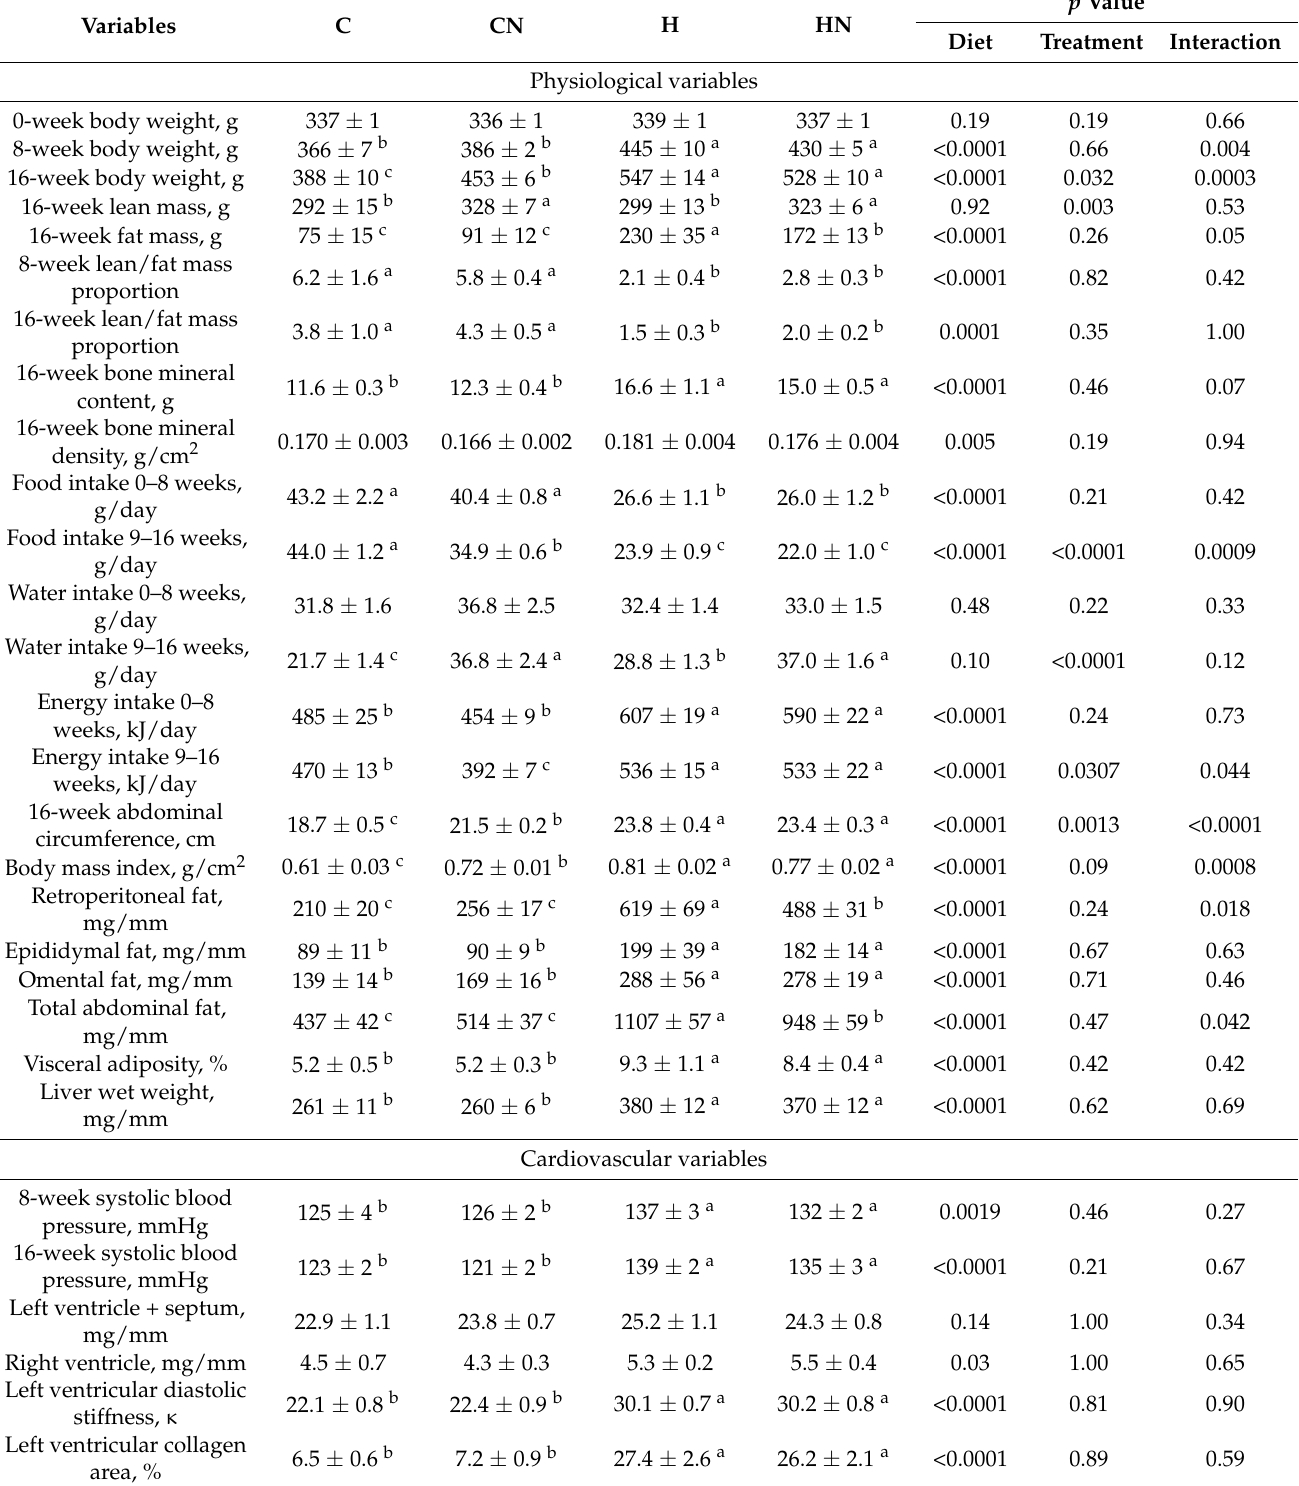
Table 2. Responses to Nannochloropsis oceanica